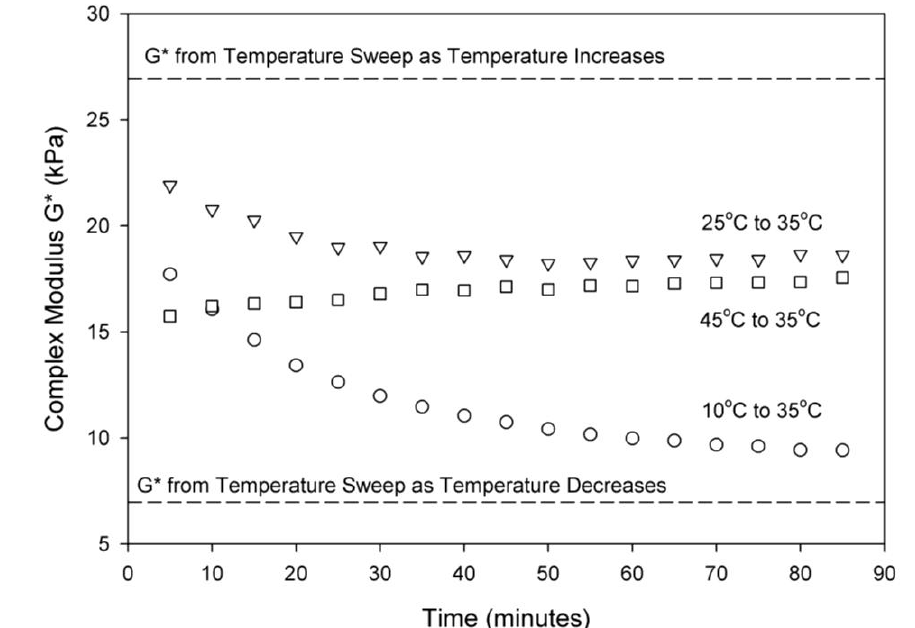
Figure 4. Transient values of the complex modulus G* at 35 °C resulting from different thermal histories are measured until a steady state complex modulus is observed. The dashed lines indicate the values from the temperature sweep in Figure 3(A) for